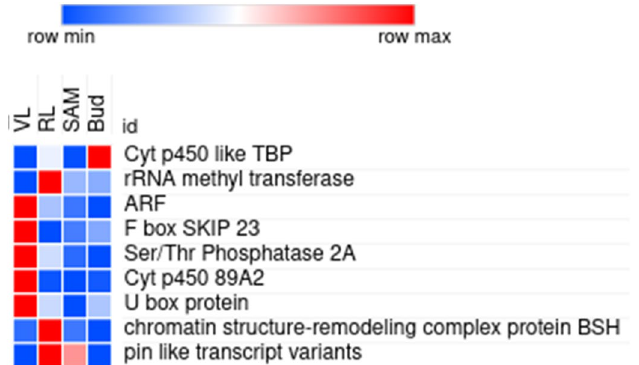
Figure 6. Expression pattern of the genes found in vicinity of associated SNPs which might have an important role in flowering. Vegetative leaves (VL), reproductive leaves (RL), shoot apical meristem (SAM) and reproductive buds